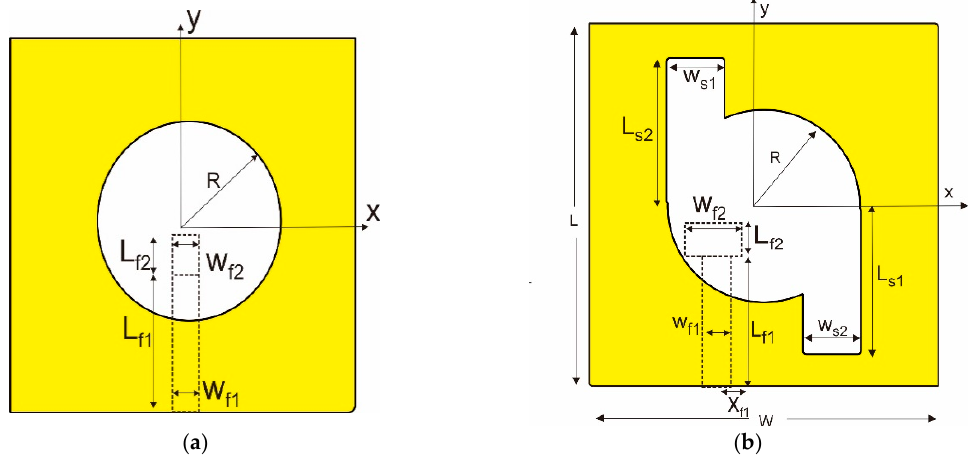
Figure 1. Geometry of a circular-slotted antenna (CSA): ( a ) conventional model and ( b ) model 1.